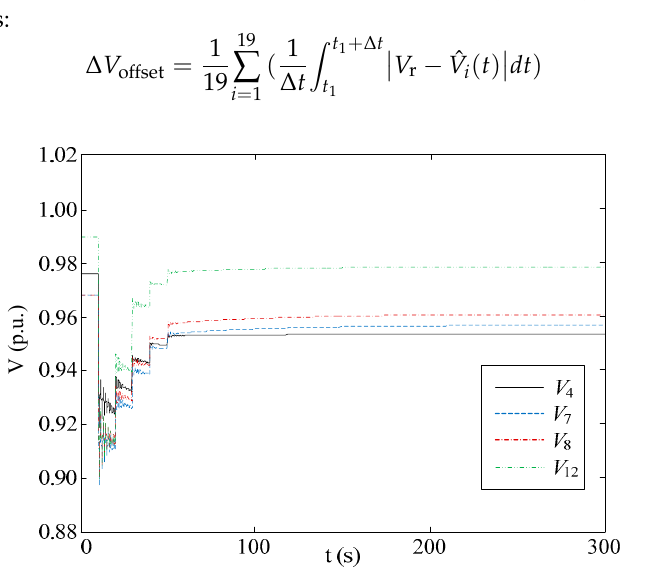
Figure 16. Voltage evolution with control in case B using constant horizon parameters.